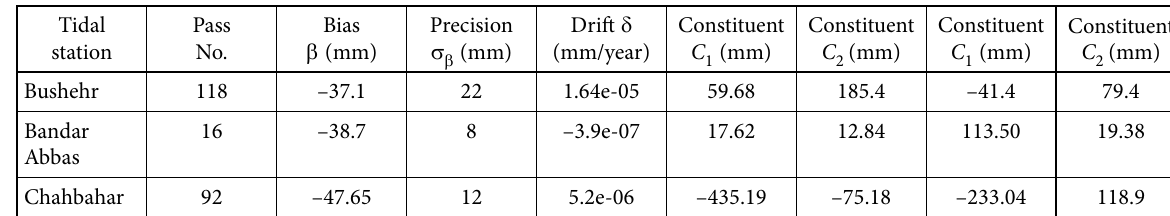
Table 5. Bias, drift and annual/semiannual constituents of Topex/Poseidon estimated by the coastal tide gauge stations located at Bushehr, Bandar Abbas and Chabahar ports